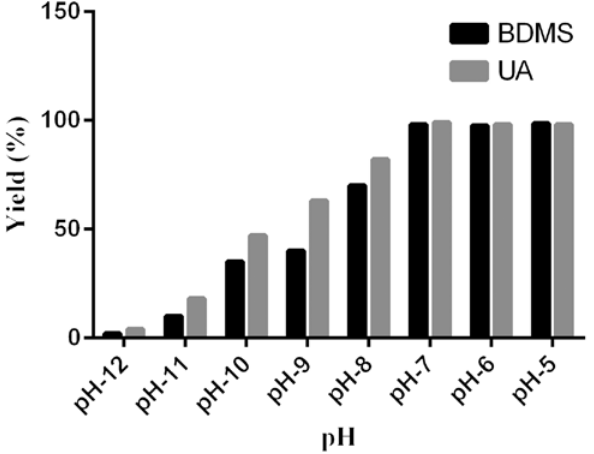
Figure 4: Effect of pH (neutralization) on yield of precipitated β , β -dimethylacryl shikonin (BDMS) (left bar) and ursolic acid (UA) (right